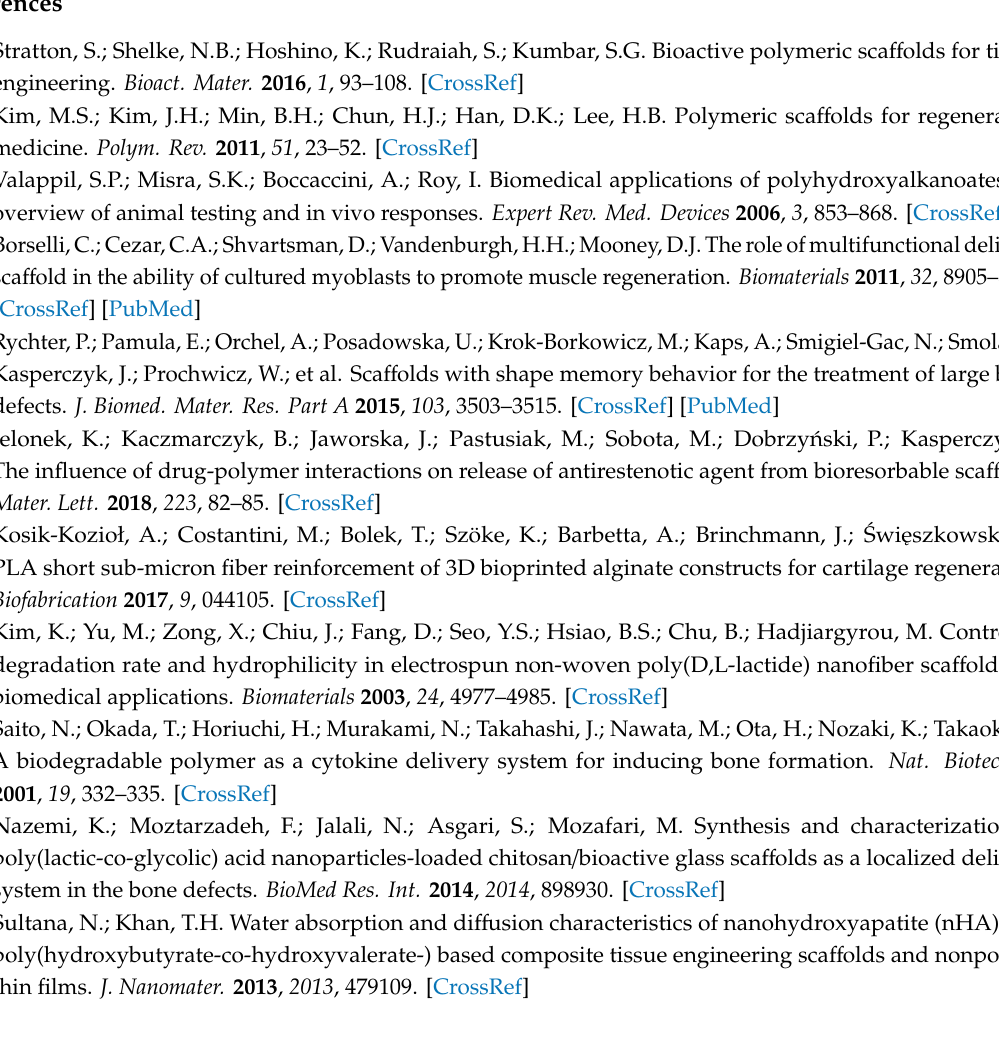
Figure S1: Scheme presenting preparation of matrices., Figure S2: P(iPrOx-nPrOx) mold during shape deformation., Figure S3: AFM and SEM micrographs for Films 1 and 3 in dry state and after incubation in water at 40 ◦ C for 2 h, Figure S4: SEM micrographs presenting a cross section of the P(iPrOx-nPrOx) films in a dry state and after incubation in water at 40 ◦ C for 2 h The thickness of the polymer layer and silica slides (approximately 500 m) are marked in the images, Figure S5: FT-IR spectrum of P(iPrOx-nPrOx) specially dried in high vacuum, Figure S6: Morphology of fibroblasts after 72 h of cell culture with laminin on: Film 2 ( a ); and TCPS ( b